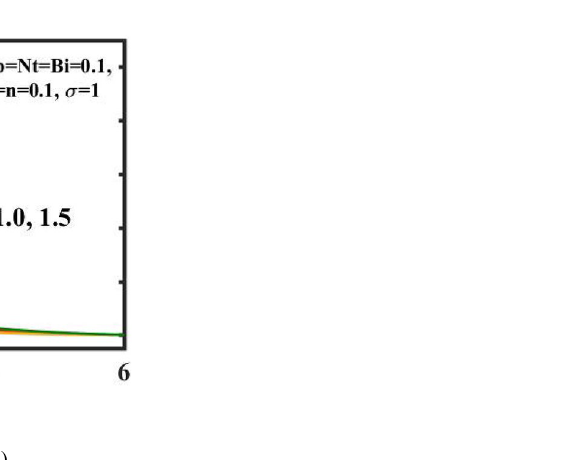
Figure 17. Encouragement of Pe on χ(η)